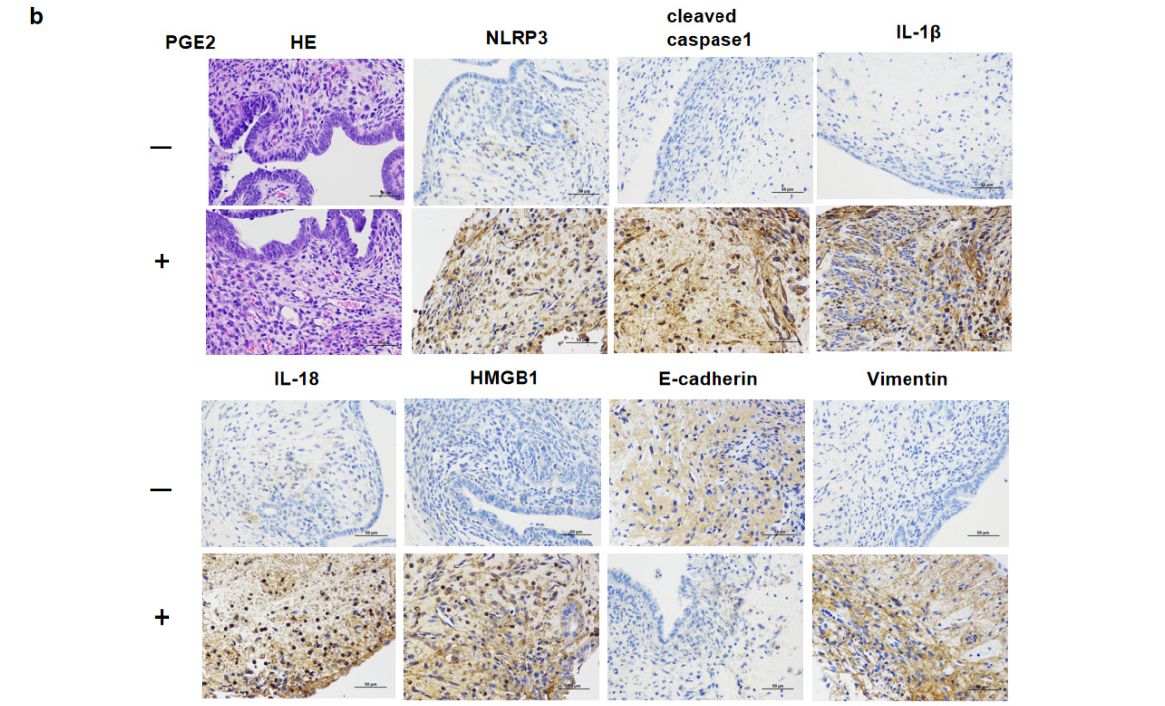
Figure 6. PEG2-induced pyroptosis pathways and invasion of EMS lesion in vivo. ( a ) After intervention with PGE2 in endometriosis mouse model, ectopic lesions were enlarged. Ectopic lesions obtained from endometriosis mice after continuous treatment with PGE2. The volume of ectopic lesions was statistically analyzed (** p < 0.05); ( b ) immunohistochemistry showed that NLRP3, cleaved caspase-1, Il-1 β , Il-18, HMGB1 and Vimentin were highly expressed in the endometrial tissues of mice treated with PGE2.E-cadherin was down-regulated in the endometrial tissues of mice treated with PGE2 (** p < 0.05).